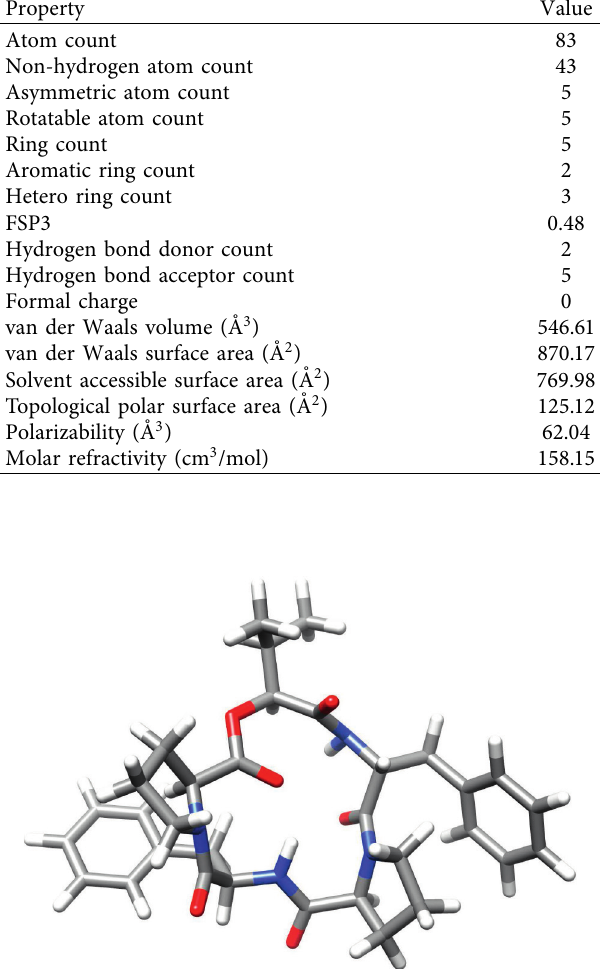
Table 2: Geometrical, structural, and physicochemical properties of the studied molecular system.